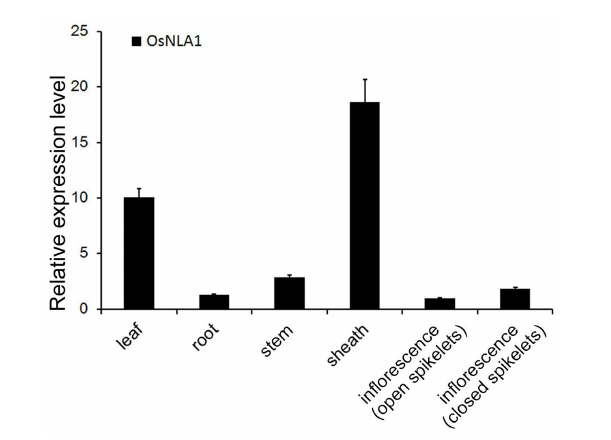
FIGURE 2 | The relative expression of OsNLA1 gene in different plant tissues. The expression of OsNLA1 gene in leaf, root, stem, sheath, and inflorescence with open and closed spikelets was measured with qRT-PCR. The inflorescence with open spikelets was set as the reference or ‘1.’ The sheath and leaf tissues had the highest OsNLA1 expression, whereas, roots and inflorescence had the least expression. Data are the means ± SD of three replicates ( n =